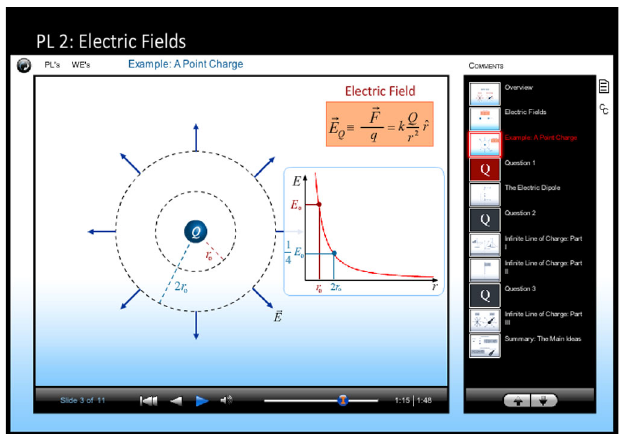
FIG. 1 (color online). Screen shot of the online multimedia prelecture on electric